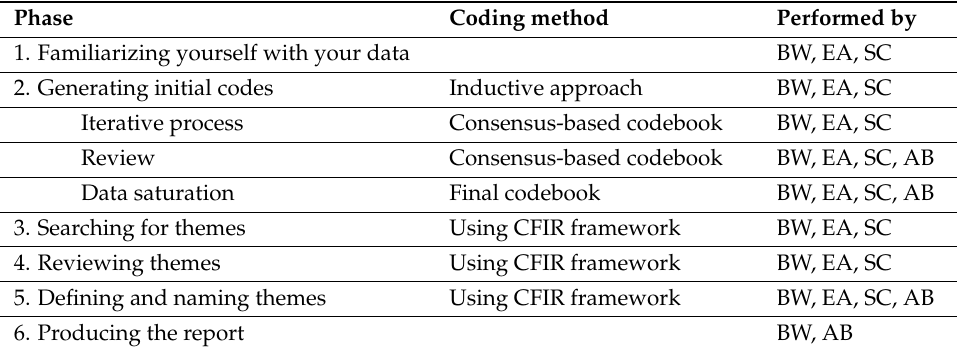
Table 2. Overview transcript